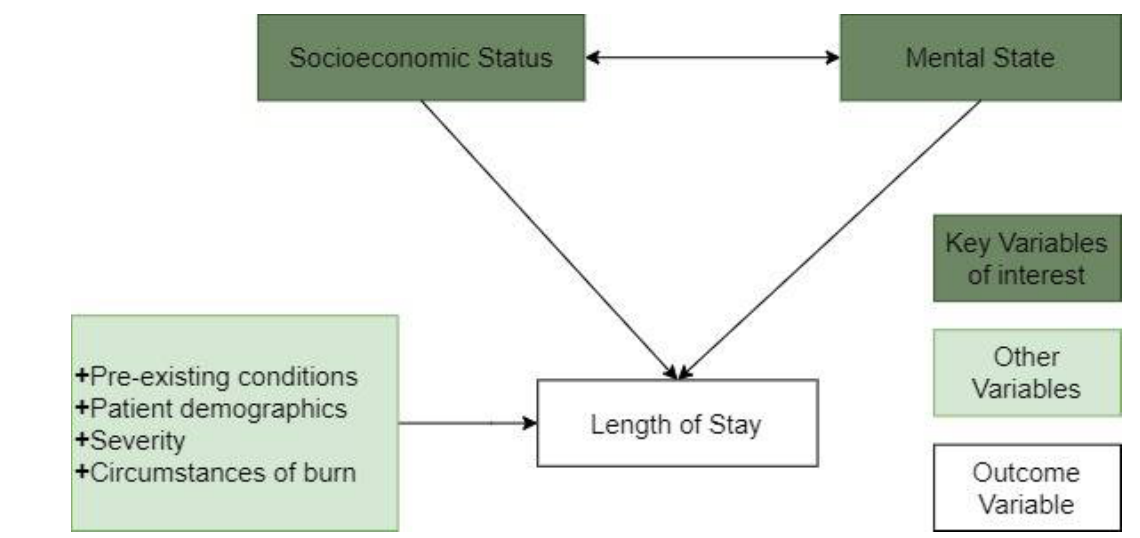
Figure 1. Relationship between socioeconomic status, psychological state, and other factors on patient length of stay (LOS).